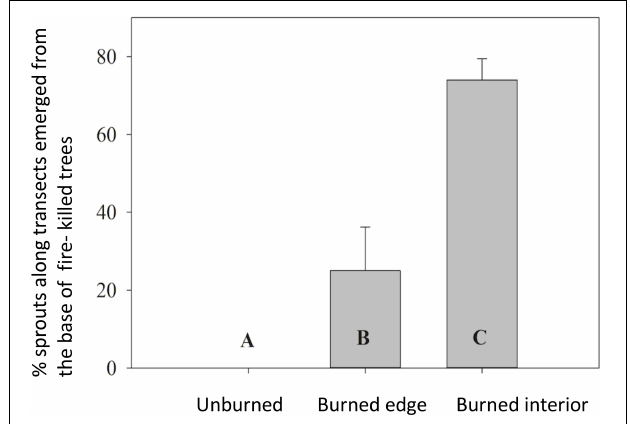
FIGURE 4 | Percent of Joshua tree sprouts ( < 1 m tall) along transect lines emerged from the base of a burned standing dead or fallen Joshua tree that died in the 2005 fire along unburned, burned edge and burned interior transects (means ± SE). Different letters denote statistically significant difference in mean values ( P < 0.05) using Tukey’s HSD.